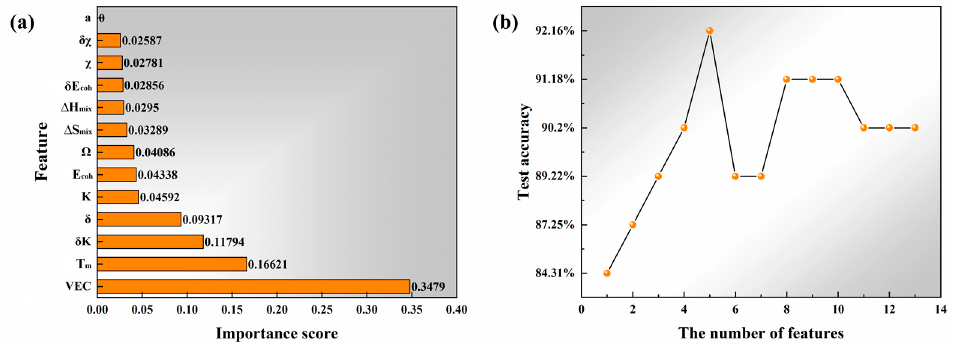
Figure 3. ( a ) Feature importance using the XGBoost algorithm, ( b ) the number of features vs. test accuracy based on XGBoost algorithm.